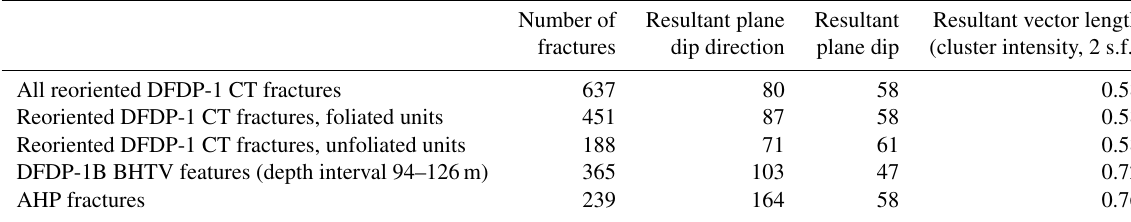
Table 1. Clustering analysis of the different fracture datasets documented in this study, using the resultant vector methodology outlined by Priest (1993). DFDP-1 foliated units comprise ultramylonites and foliated cataclasites (units 1, 2, and 4 of Toy et al., 2015). DFDP-1 unfoliated units comprise unfoliated cataclasites (unit 3 of Toy et al., 2015). The resultant vector orientation for each dataset, which has been converted to spherical coordinates, is also reported. See text for full details. The term “s.f.” indicates significant figures. Number of Resultant plane Resultant Resultant vector length fractures dip direction plane dip (cluster intensity, 2 s.f.)